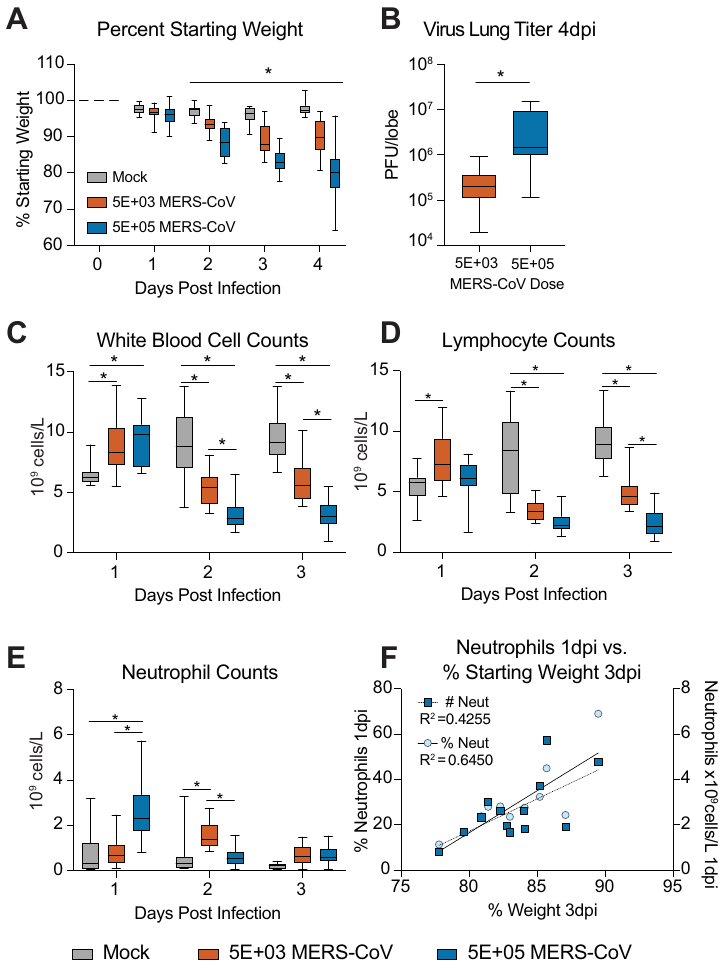
Fig 5. Numbers of peripheral blood leukocytes on day 1 post infection are predictive of MERS-CoV disease severity. (A) Percent starting weight of mock infected (N = 10) or those infected with either 5E+03 (N = 13) or 5E+05 (N = 13) PFU MERS-CoV maM35C4. Daily blood samples were obtained by submandibular bleed for each mouse on 1, 2, and 3dpi. (B) MERS-CoV virus lung titer on 4dpi via plaque assay. The asterisk indicates a statistically significant difference (P = 0.004) by Mann-Whitney test. (C) The numbers of white blood cells in mock or MERS-CoV infected mice described in A . (D) The numbers of lymphocyte cells in mock or MERS-CoV infected mice described in A . (E) The numbers of neutrophil cells in mock or MERS-CoV infected mice described in A . For the box and whisker plots in A , B , C , D and E , the line is at the median, the box extends from the 25 th to 75 th percentile and the whiskers encompass the range. For A , C , D and E , the asterisk indicates statistically different values by Two-Way ANOVA with Sidek’s multiple comparison test. (F) Weight loss on 3dpi in high dose MERS-CoV (5E+05 PFU) infected mice is correlated with % neutrophils in peripheral blood on 1dpi. Linear regression was performed to determine correlation. The goodness of fit R 2 value is shown in the plot. PFU) mice in Fig 2C, we observed virus dose dependent differences in this metric when com- paring mock, sublethal and lethal doses of MERS-CoV (Fig 5C). Although there was an increase in WBCs with both doses of virus on 1dpi as compared to mock infection, on 2 and 3dpi leukopenia was observed (Fig 5C). CBC derived from cardiac puncture and submandibu- lar bleed of mice have been shown by others to be equivalent[17]. Thus, the differences in WBC trends in Figs 2 and 5 are not likely because of bleeding route and are more likely related to the differences in virus dosage and/or slight differences in the numbers of measured cells (i.e. lymphocytes, monocytes, neutrophils, etc.) which revealed (Fig 5) or obscured (Fig 2)